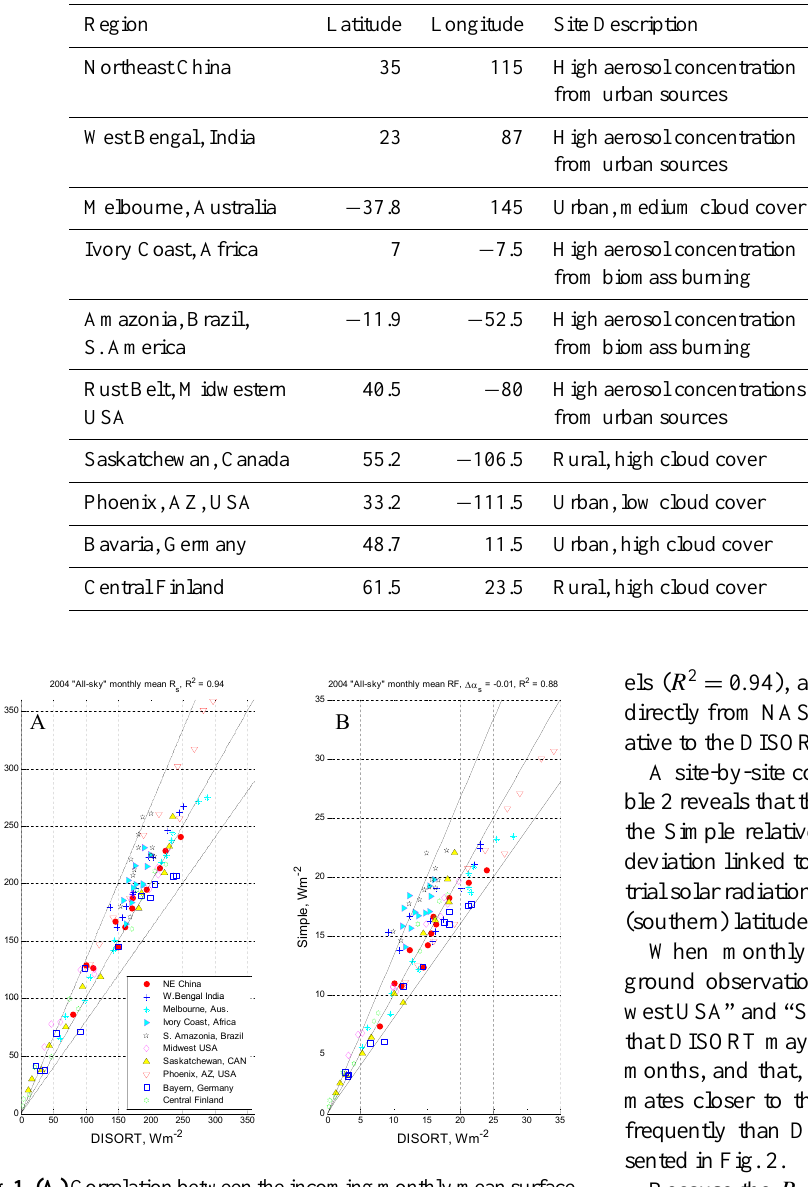
Fig. 1. (A) Correlation between the incoming monthly mean surface solar flux R s (B) and monthly shortwave radiative forcings at TOA computed by the Simple and DISORT models.